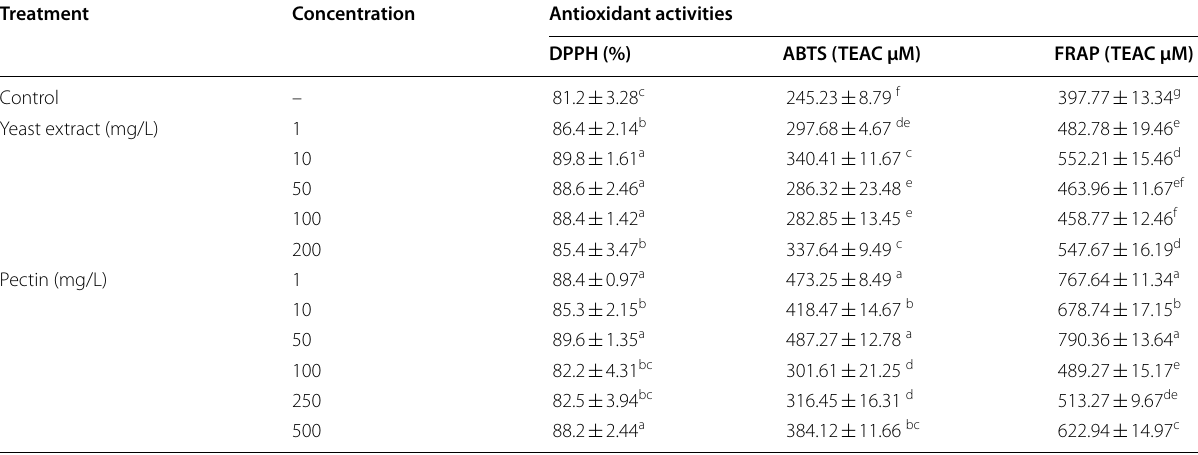
Values represent means standard errors from triplicates; different letters indicate significant differences at p < 0.05 ± Table 3 Anti‑inflammatory activity of Ajuga integrifolia agitated micro‑shoots (Cyclooxygenases (COX1, COX2); Secretory phospholipase A2 (sPLA2); Lipoxygenase (15‑LOX))